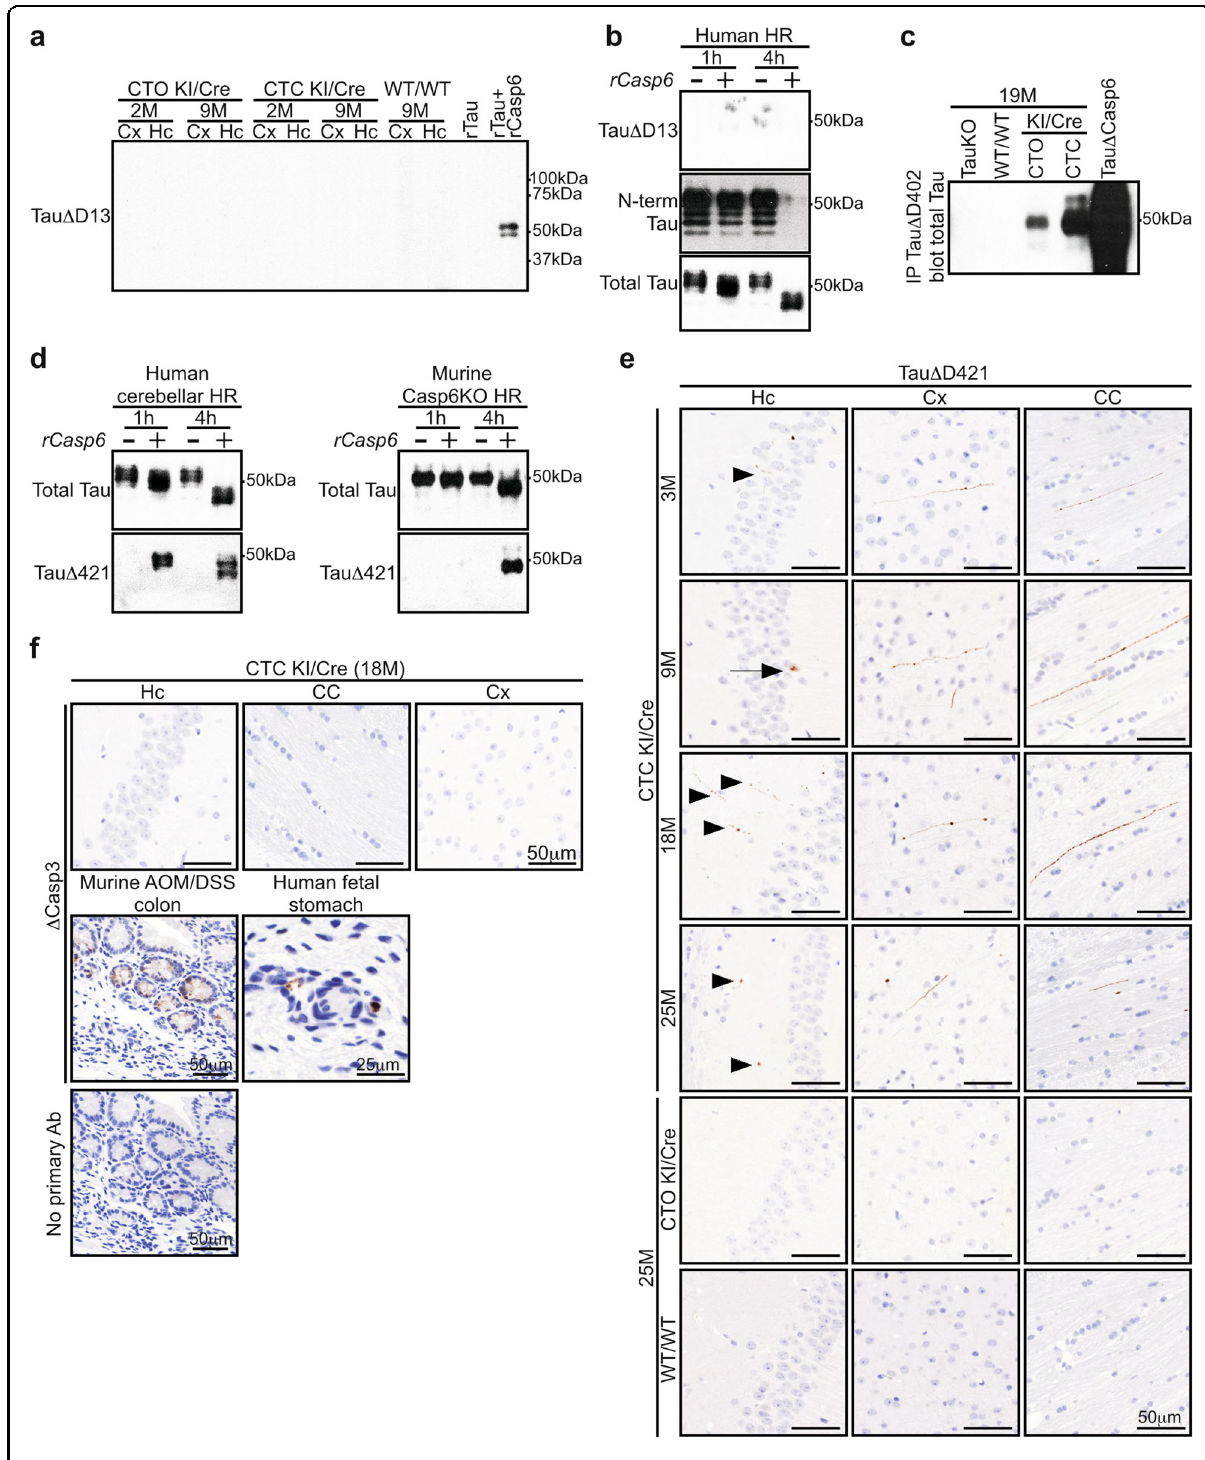
Fig. 2 (See legend on next